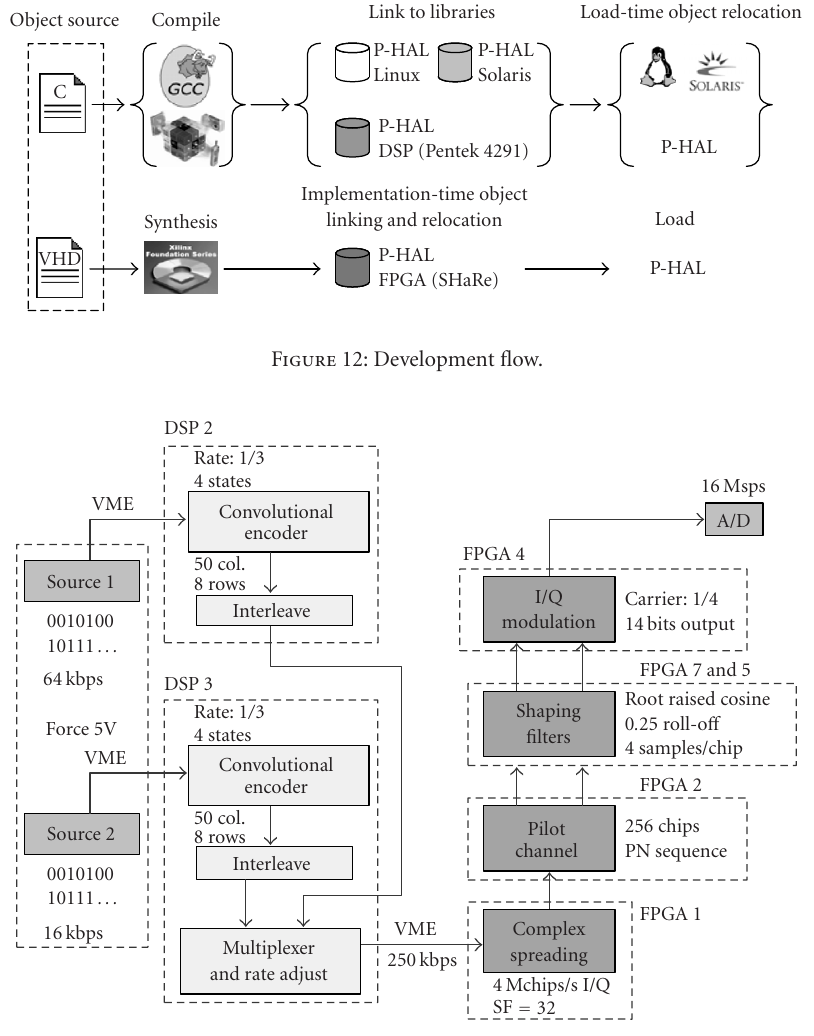
Figure 13: QPSK CDMA